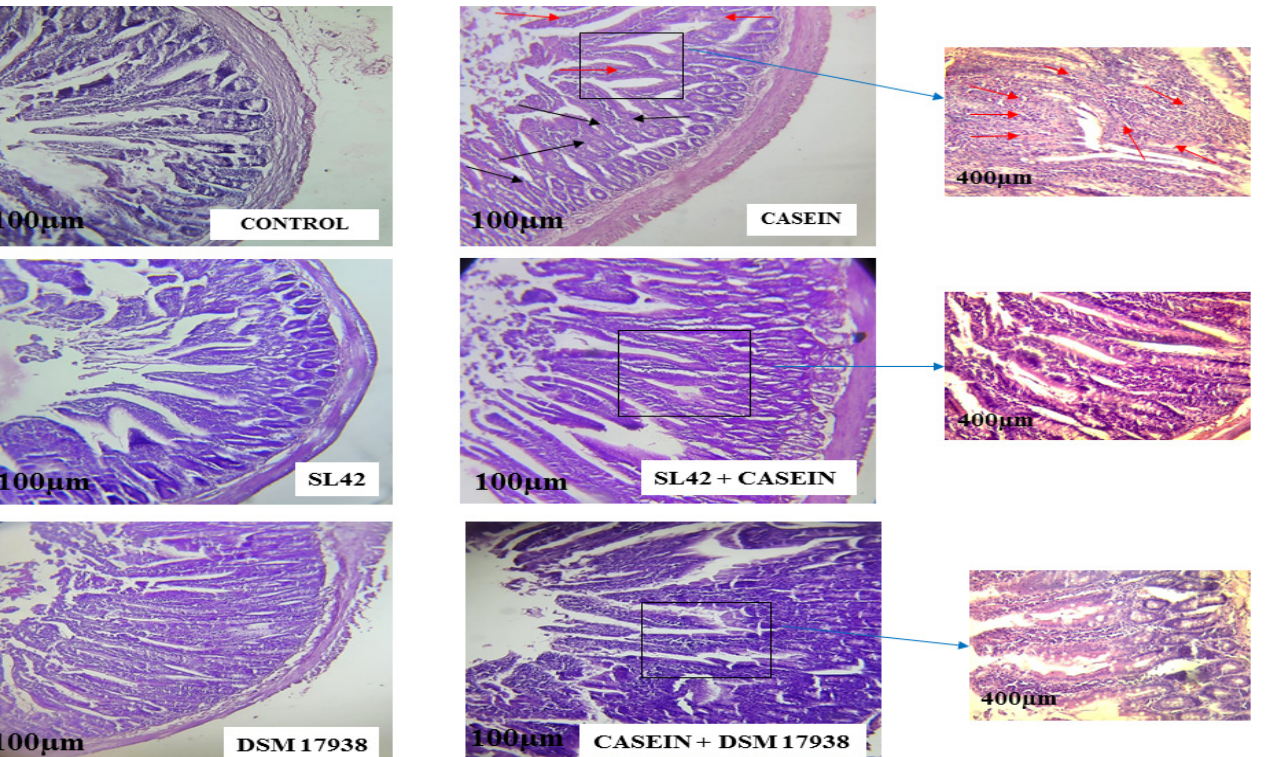
Figure 8. Representative HE-stained sections of jejunal mucosae are shown at original magnification, 100 μ m. Wistar rats were sensitized intragastrically by administration of casein without adjuvant. The rats were fed every other day ( − 3rd to 58th day) with L. rhamnosus SL42 or L. reuteri DSM 17938 at 1 × 10 8 CFU/mL. The dose volume was 1 mL. The black and red arrows indicate eosinophil infiltration and goblet cells, respectively. Control group receiving only PBS (control); casein-sensitized group (casein); nonsensitized group treated with SL42 strain (SL42); casein-sensitized group treated with SL42 (Casein + SL42); nonsensitized group treated with DSM 17938 strain (DSM 17938); and casein-sensitized group treated with DSM 17938 strain (Casein- + DSM 17938).